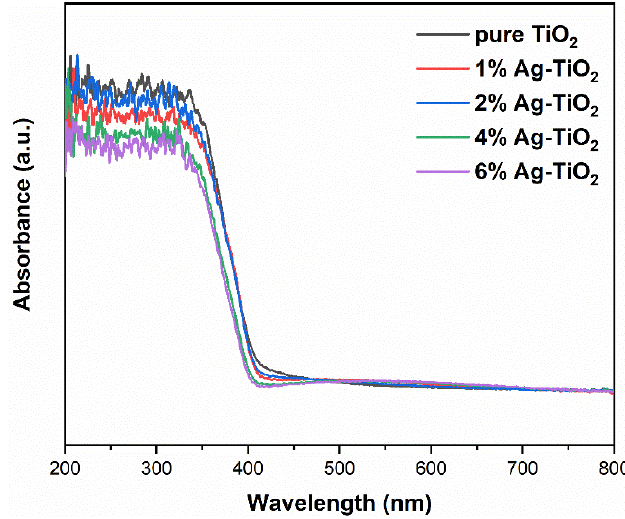
Figure 8. DRS spectra of pure TiO 2 and Ag-TiO 2